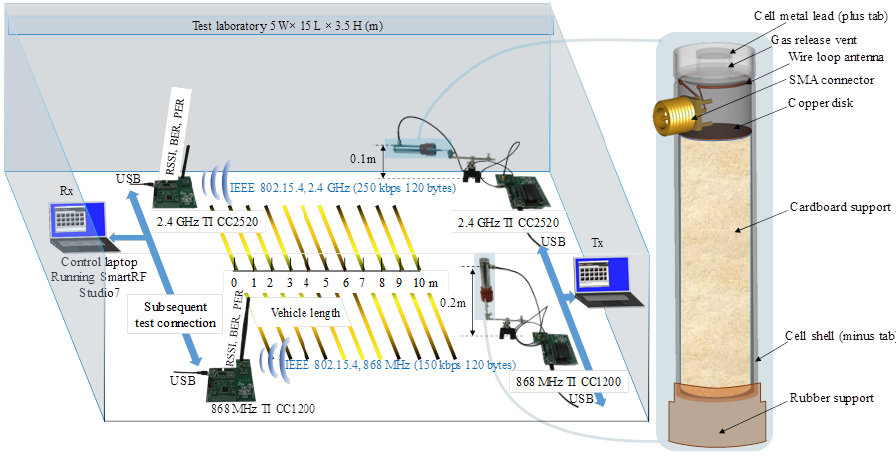
Figure 4. Experimental test setup for 868 MHz and 2.4 GHz communication range testing inside the laboratory. The radiative structure of an 18650 Li-ion shell vertical and horizontal oriented versus the ground plane is showed for the transmitter part (Tx), whereas the receiving unit (Rx) equipped with a standard antenna tuned for the communication frequencies is moved and interchanged subsequently